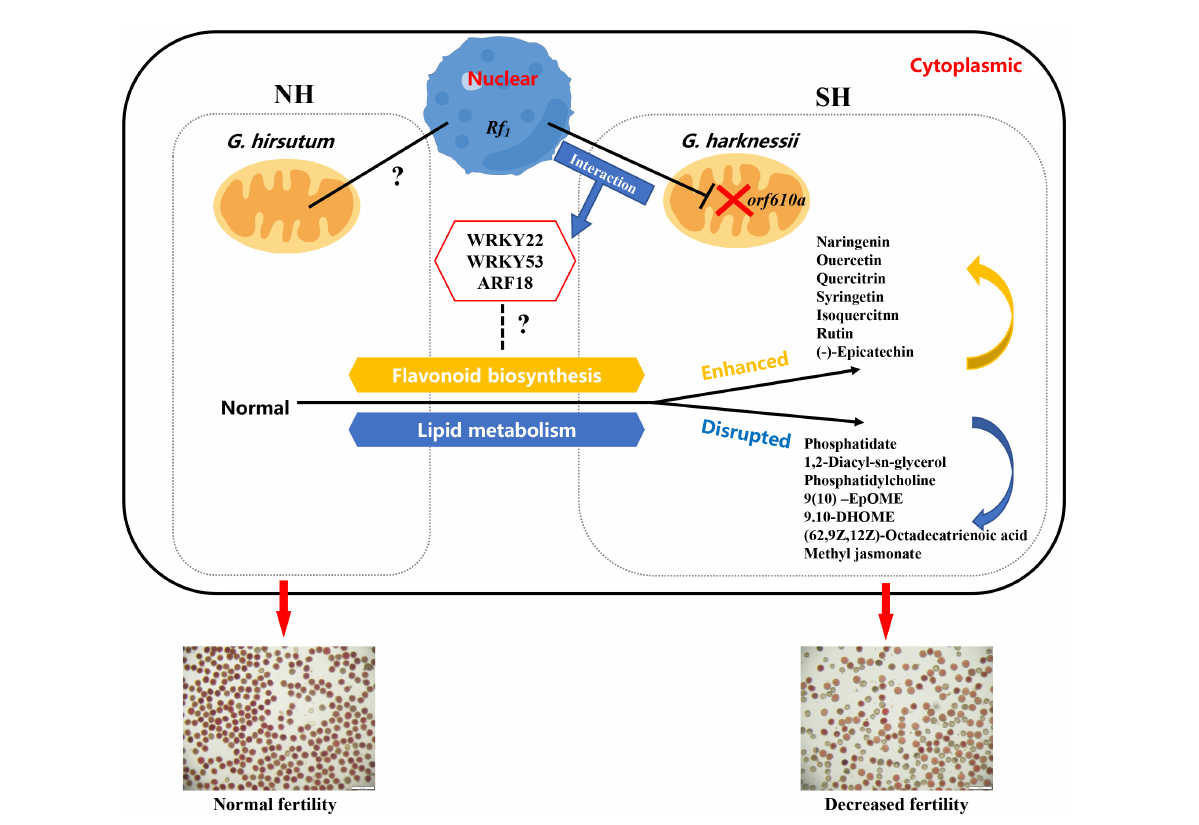
FIGURE8 A proposed model showing the main factors affecting pollen fertility of restorer lines with different cytoplasms in the presence of restorer gene